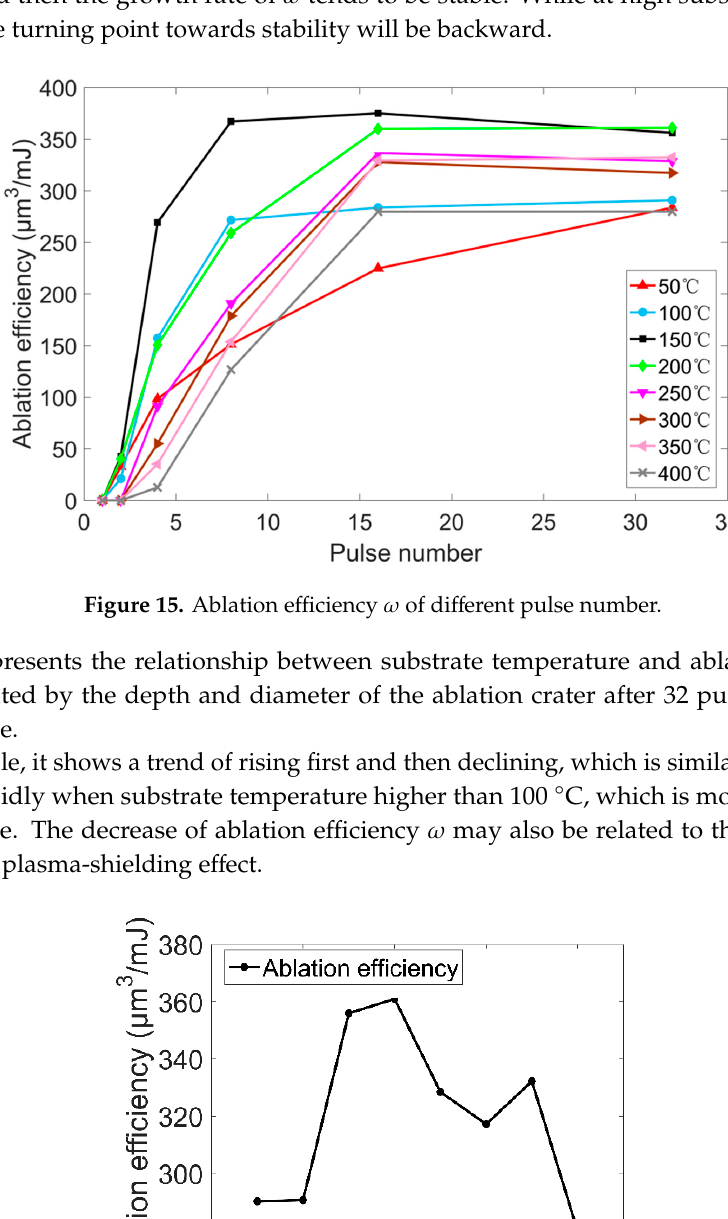
Figure 16. Ablation efficiency ω after 32 pulses irradiation at substrate temperatures of 50–400 °C.